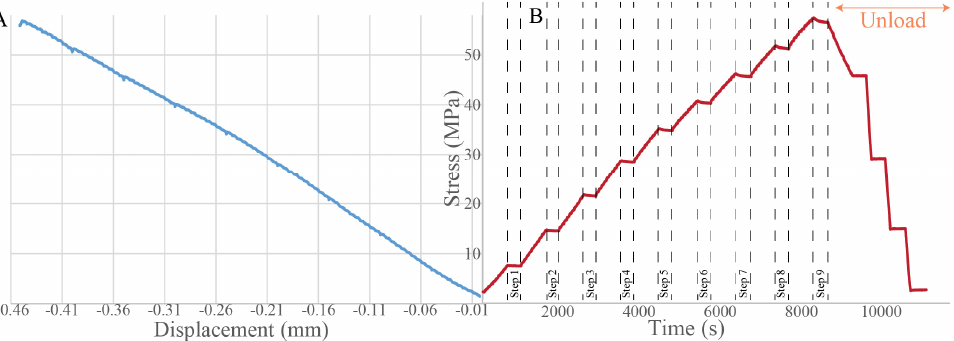
Figure 6. Example of a curve obtained during an in-situ SEM experiment of a Carrara marble sample. The displacement speed of the piston is constant during the whole loading period at 8.10 − 5 mm/s. ( A ) Loading curve of the stress applied on the sample surfaces as a function of the piston displacement. ( B ) Curve of stress versus time.